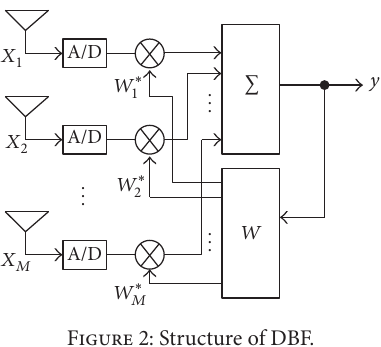
Figure 2: Structure of